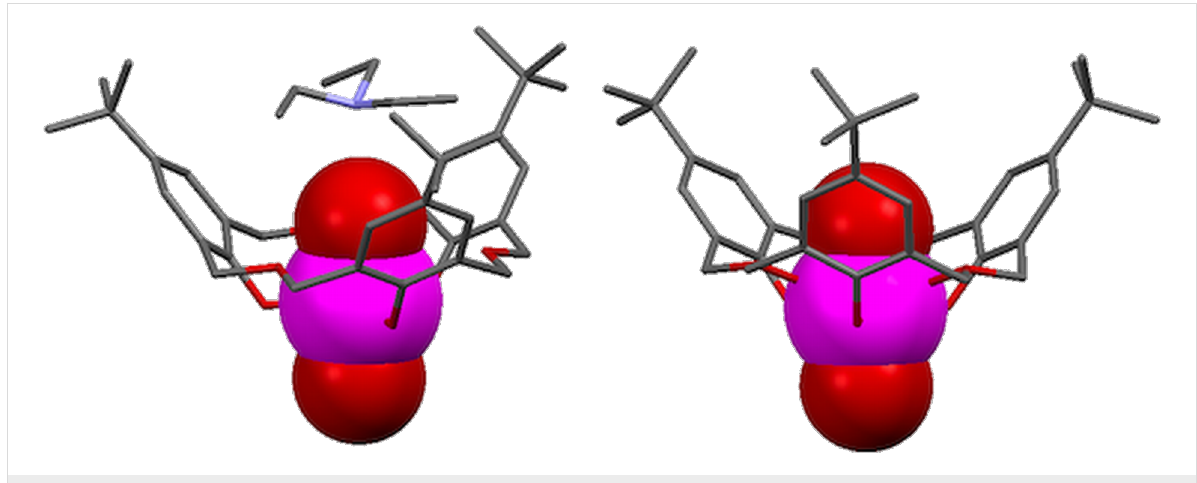
Figure 18: X-ray crystal structures of [ 3a ∙ UO 2 ] − with a cavity-bound cation (CCDC ID 135575, left) and without a coordinated cation (CCDC ID 181042, right) [62,63].